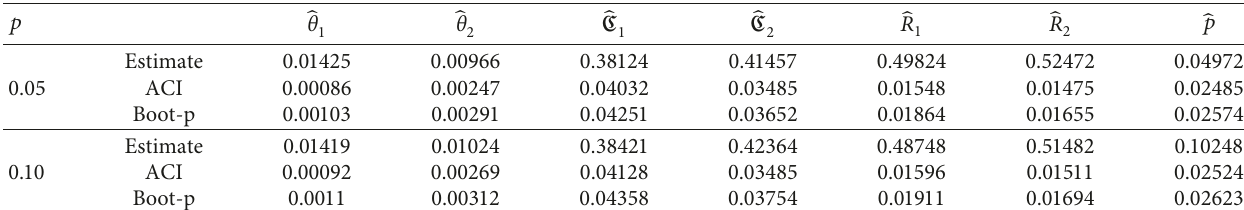
Table 20: ML estimates of parameters and related function with their CIs for different m of n and p for real data.